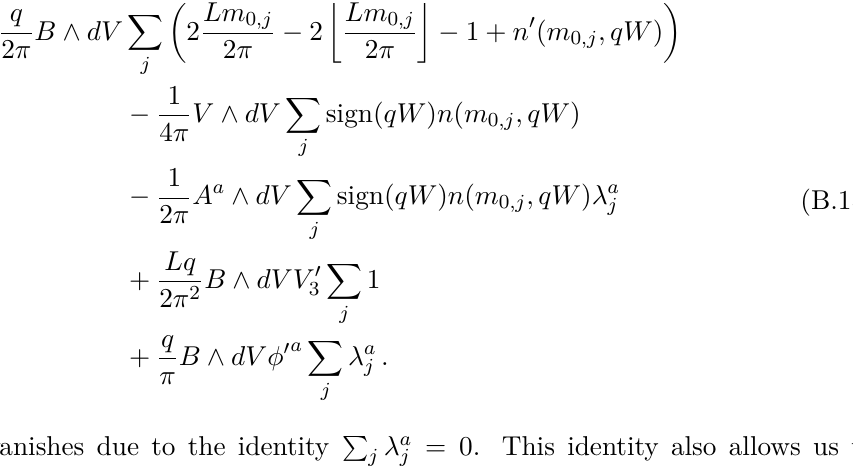
we can merely adapt the outcomes of our calculations involving the A and φ 0 terms.